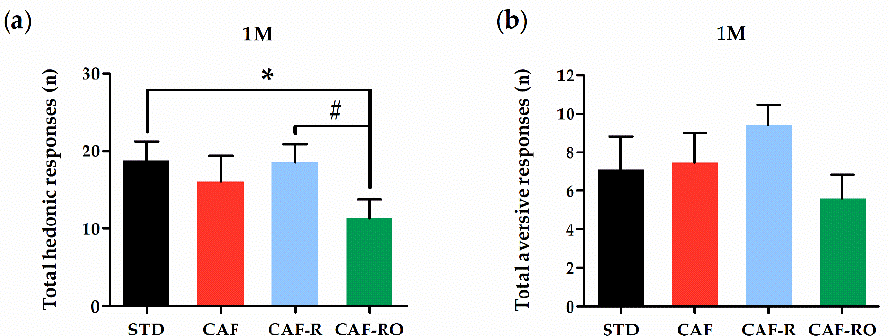
Figure 5. Total hedonic ( a ) and aversive ( b ) responses at the 1 M sucrose concentration in the taste reactivity test. The total number of hedonic responses was calculated as the sum of tongue protrusion, paw licking and mouthing responses. The total number of aversive was calculated as the sum of head shaking, forelimb flailing, snout cleaning and gagging responses. Data are expressed as the mean ± SEM. * p < 0.05 STD vs. CAF-RO group; # p < 0.05 CAF-R vs. CAF-RO group.